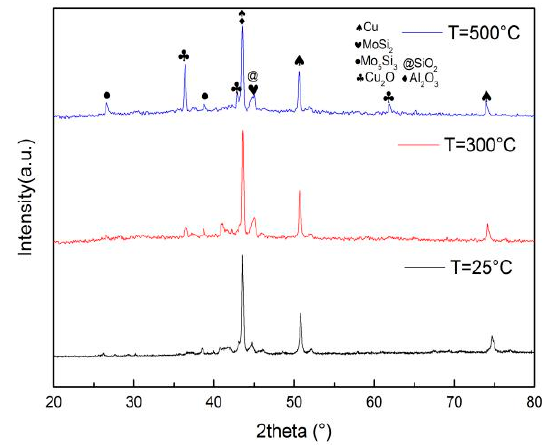
Figure 3. XRD patterns of Al 2 O 3 -MoSi 2 -Cu coatings at different temperatures.